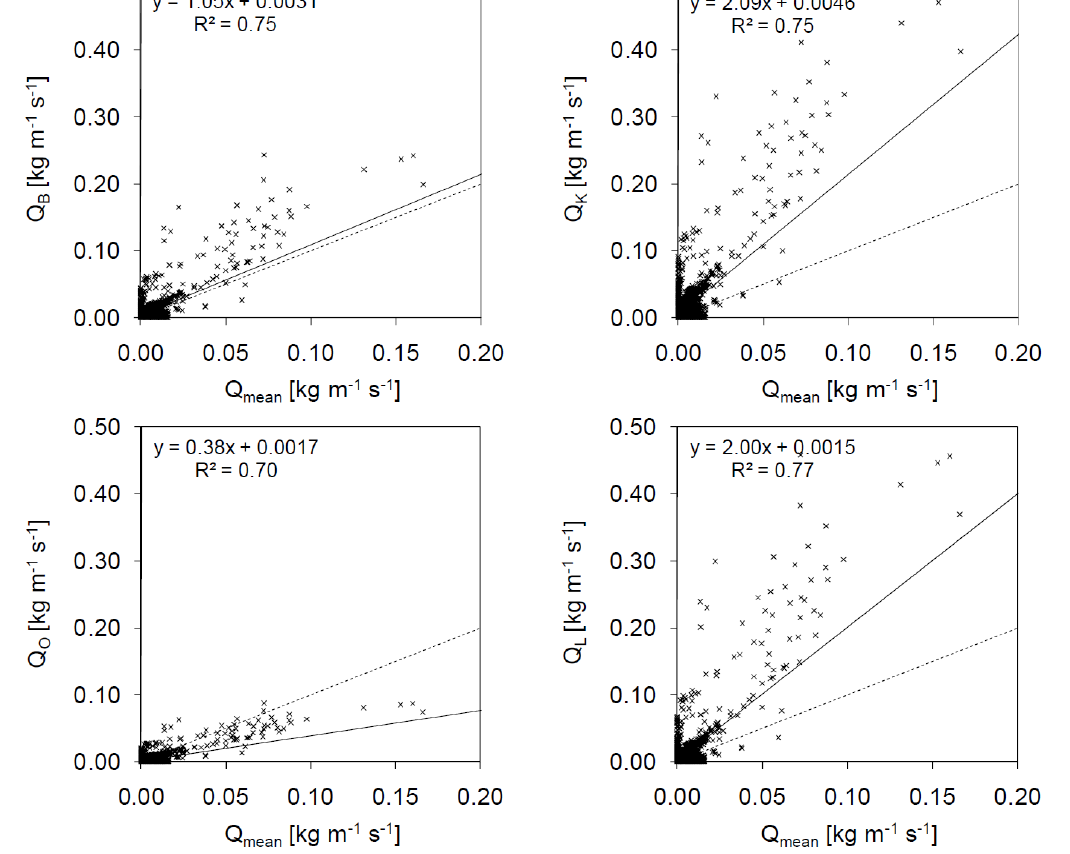
estimated from n with Q , Q , Q , and Q estimated using mean B K O L > u ( i.e. , u > 4.05 m s –1 ) during periods * * t